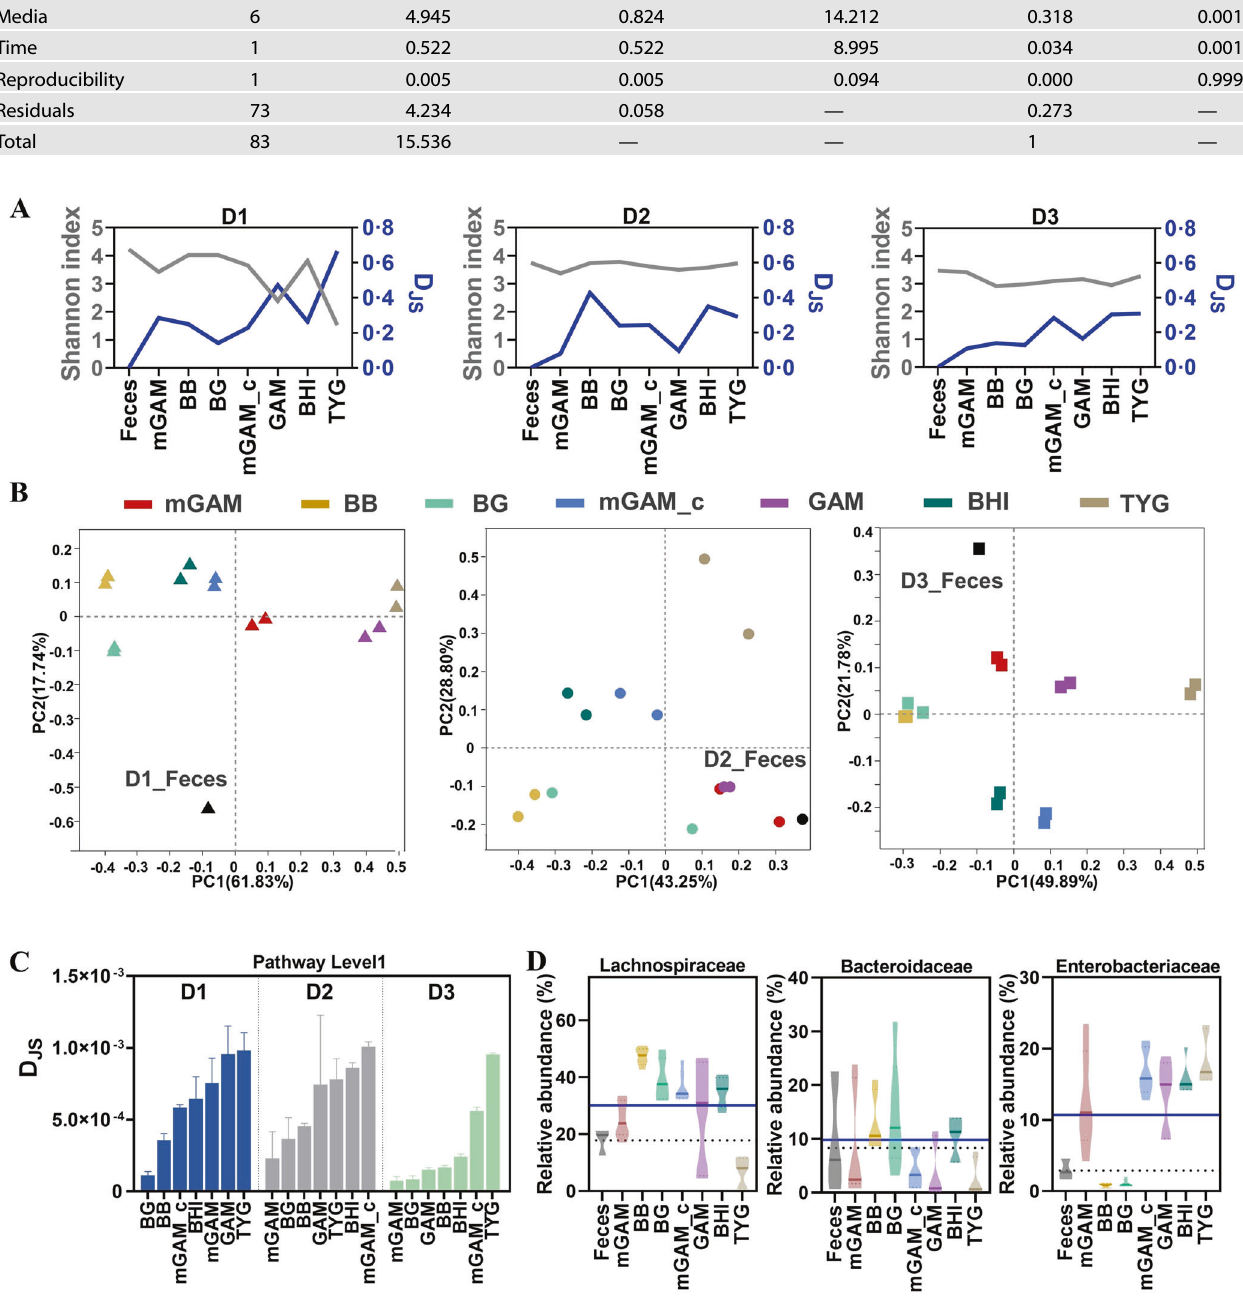
Fig. 3 Screening of different culture media. A Shannon index at the ASV level and D JS at the family level. B Bray curtis based Principal co- ordinates analysis (PCoA) among the samples at genus level. C D JS from the fecal sample, computed at the pathway level 1. D Abundance of top 3 gut microbiota at the family level (dashed line means the abundance of gut microbiota in fresh feces, solid line means the average abundance of gut microbiota in 7 media). Personalized drug metabolism by human gut microbiota and SCFAs metabolism enzyme bcoA, bsh and baiJ , and D JS value at ex vivo pathway level 1 (Fig. S7C, D). Based on the optimized GB medium for human fecal bacteria Taken together, a comprehensive ranking was calculated by culture, we next explored the impacts on drug metabolism by including bacteria growth, α and β diversity, and bacterial functions, individual gut microbiome from different donors. Three representa- which indicated that GB medium was superior to the other two tive drugs were trialed by gut microbiome from ten individual media based on the multi-dimensional evaluation (Fig. 5).